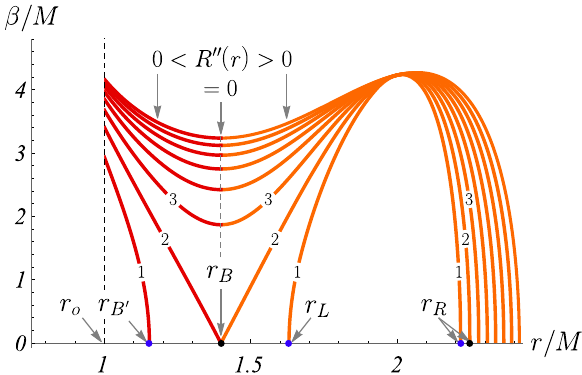
Fig. 6 Dependenceoftheimpactparameter β ontheradialdistancefor differentspinparameters.Threerepresentativebehaviorsaredenotedby numbers. For spin parameters a > a single real root, and a minimum at R (cid:6)(cid:6) ( r ) = 0 (curve 3). For a = a additional double root arises at R (cid:6)(cid:6) ( r ) = 0 (curve 2). For a < a real roots exist corresponding to the location of unstable/stable light rings (curve 1). The unstable spherical orbits are depicted in orange, while the stable ones are in red